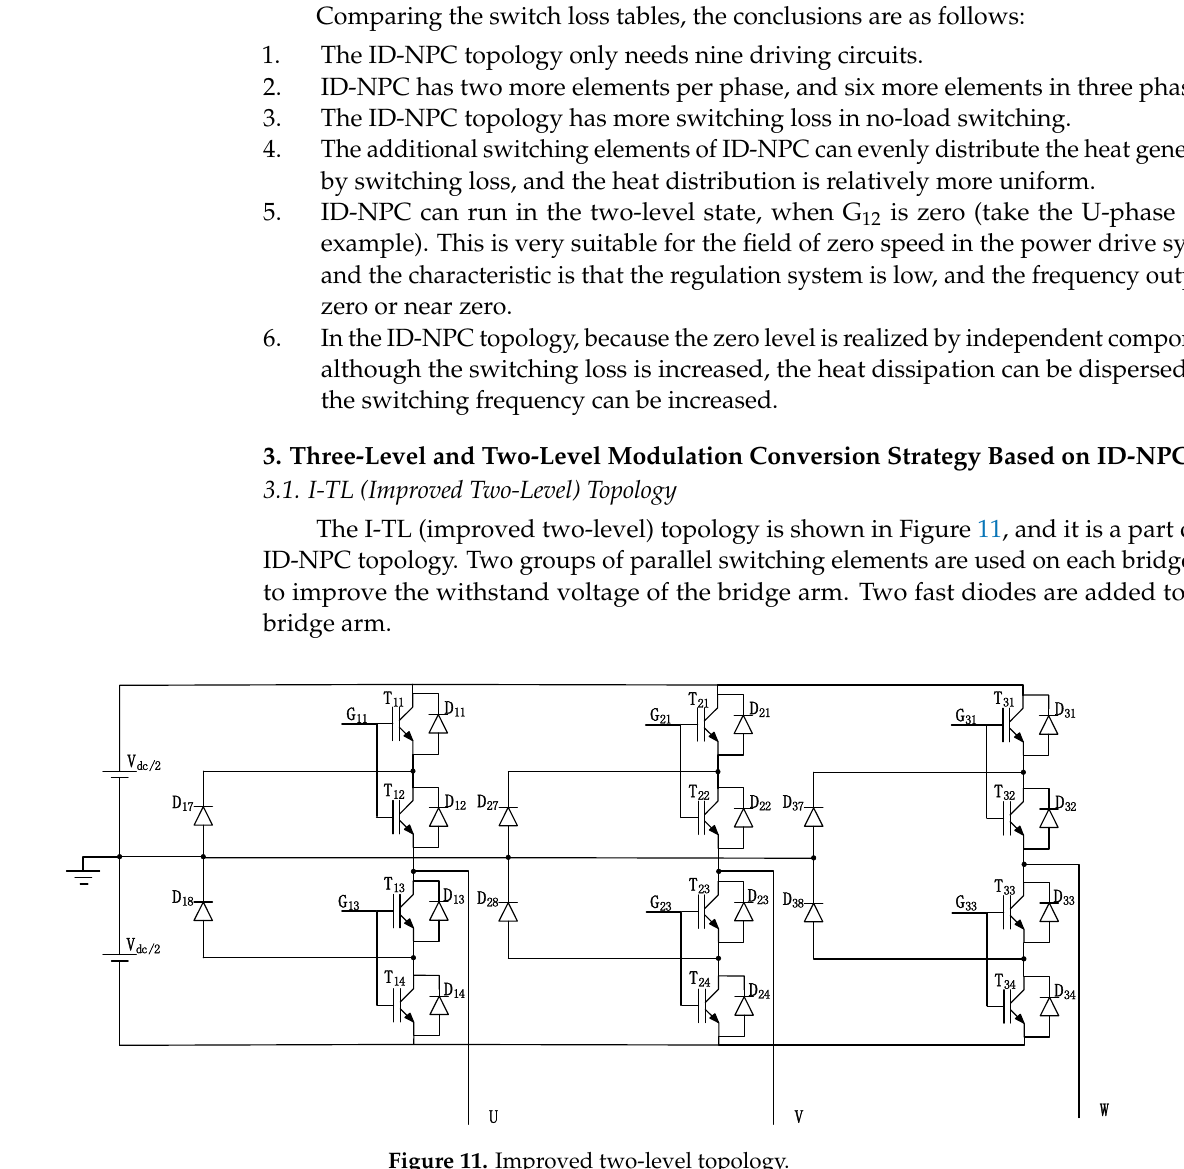
Figure 11. Improved two-level topology.